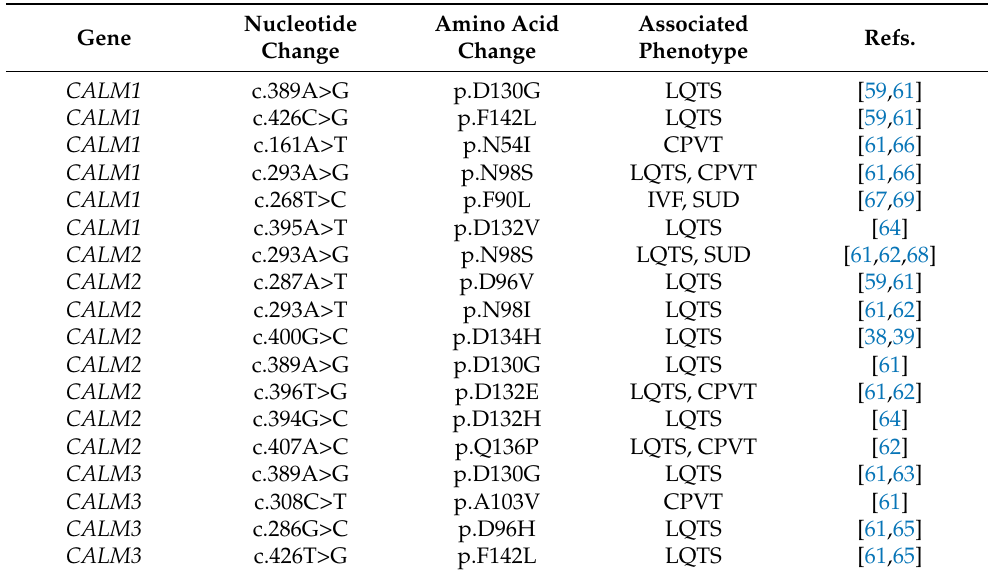
Table 1. List of the main human CaMs gene polymorphisms. CaM polymorphisms are associated with a spectrum of arrhythmic phenotypes. Adapted from Kotta et al. [61]. Gene